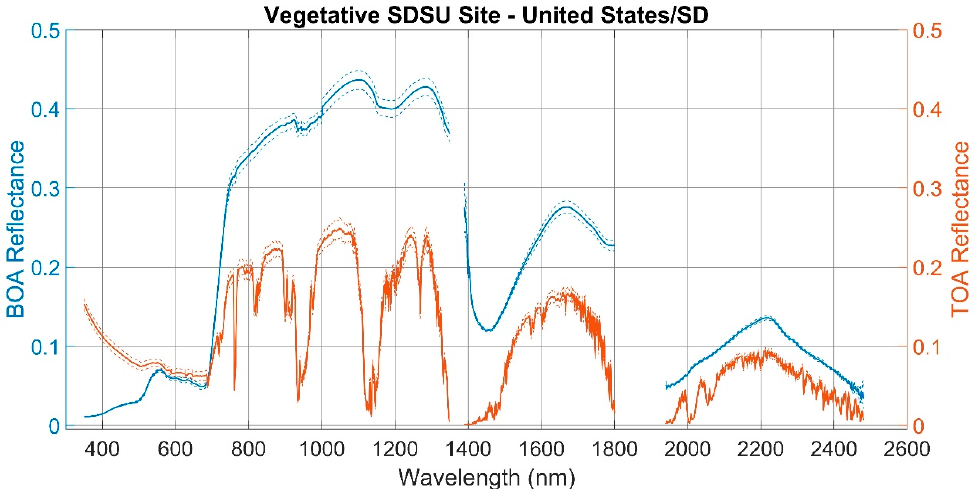
Figure 5. In the y -axis left and right side of the graph is presented, respectively, the BOA and TOA reflectance of South Dakota State University (SDSU) Vegetative site measured in-situ on 9 October 2019.